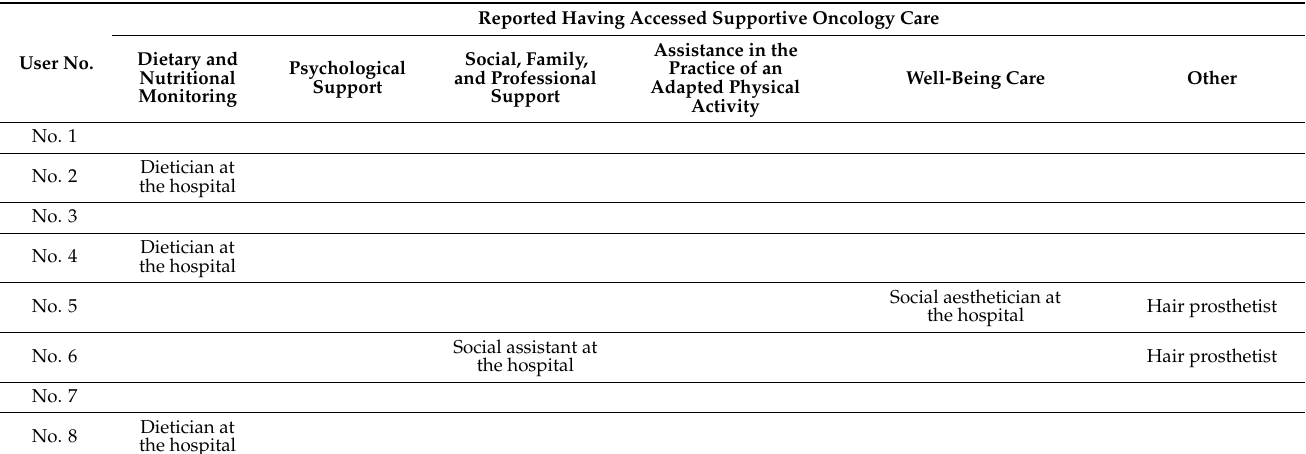
Table 2. Information on how interviewees with cancer accessed